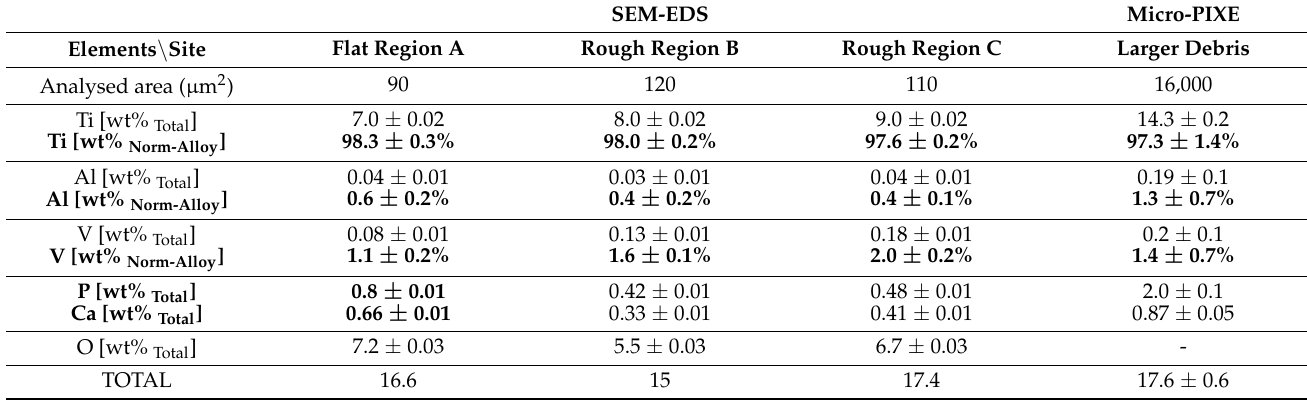
Table 1. Total and normalized weight percent (wt%) of Ti 6 Al 4 V alloy debris and adsorbed elements on the marked distinct topographical regions. Initial wt% of the alloy components were 90% Ti, 6% Al and 4% V. For the elemental analysis of the same sample site on the wider FoV using SEM-EDS, see the Figure S9 in the Supplementary Materials.